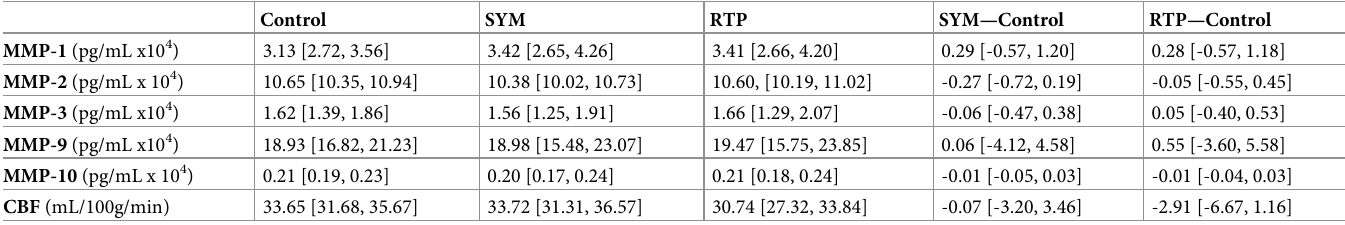
The mean MMP and CBF values are reported for athletic controls and for concussed athletes at early symptomatic injury (SYM) and return to play (RTP), along with bootstrapped 95%CIs of the mean. The mean differences between concussed and control groups and 95%CIs are also reported for each post-concussion imaging session. None of the comparisons between concussed and control groups attained a value of p < 0.05,